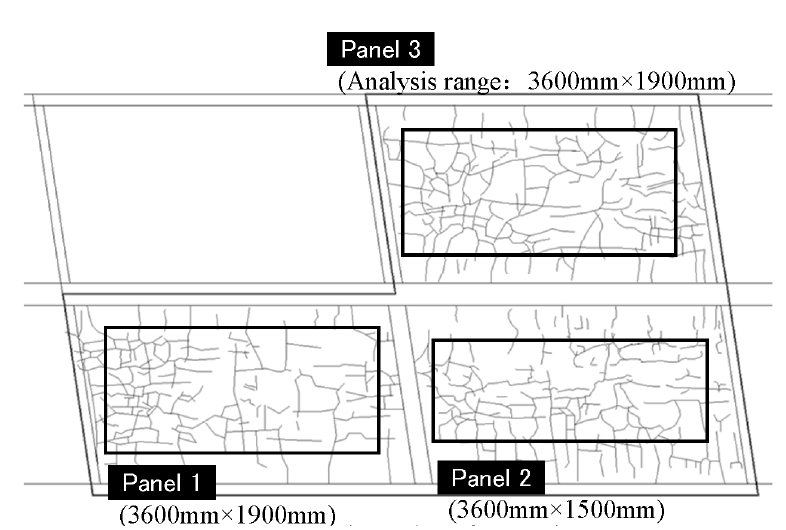
Figure 1. A top side view of subject bridge.